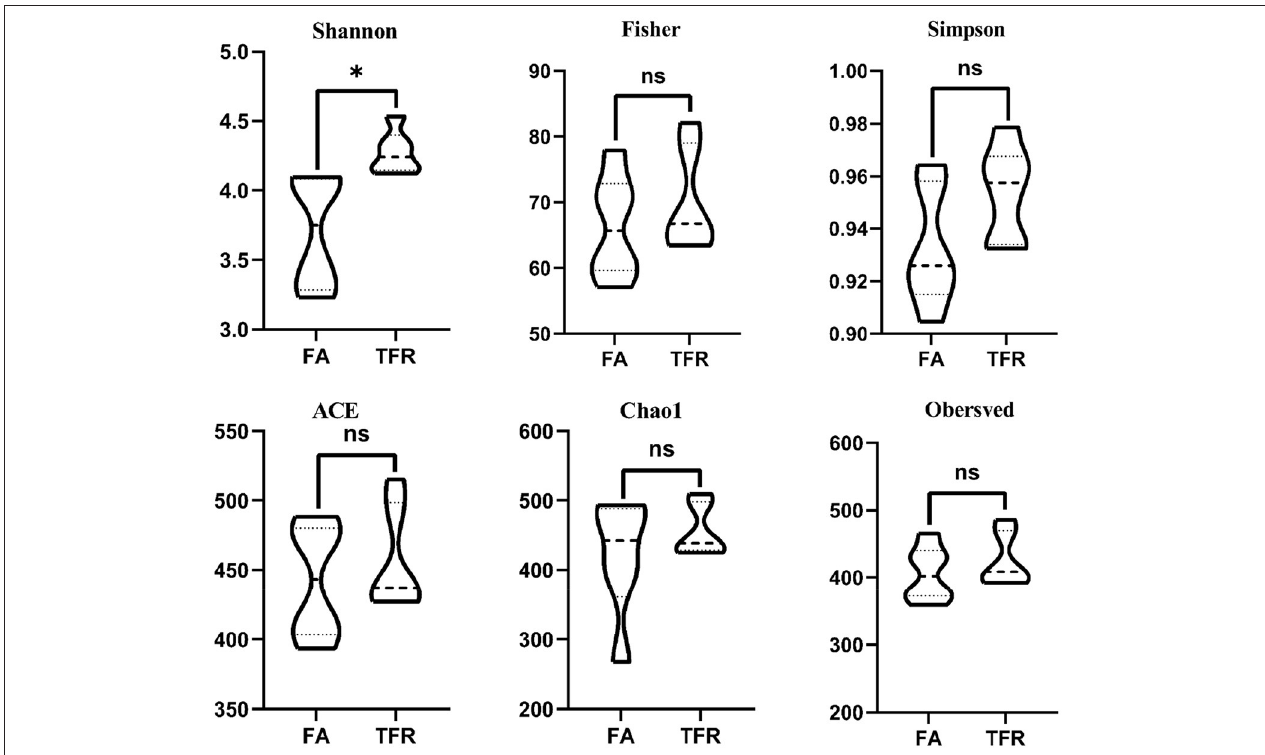
FIGURE 1 | Differences in the colonic bacterial α -diversity index of growing pigs between the FA and TRF groups. FA, free access group; TRF, time-restricted feeding group. *Indicates a significant difference between the two groups; ns represents no significant difference.